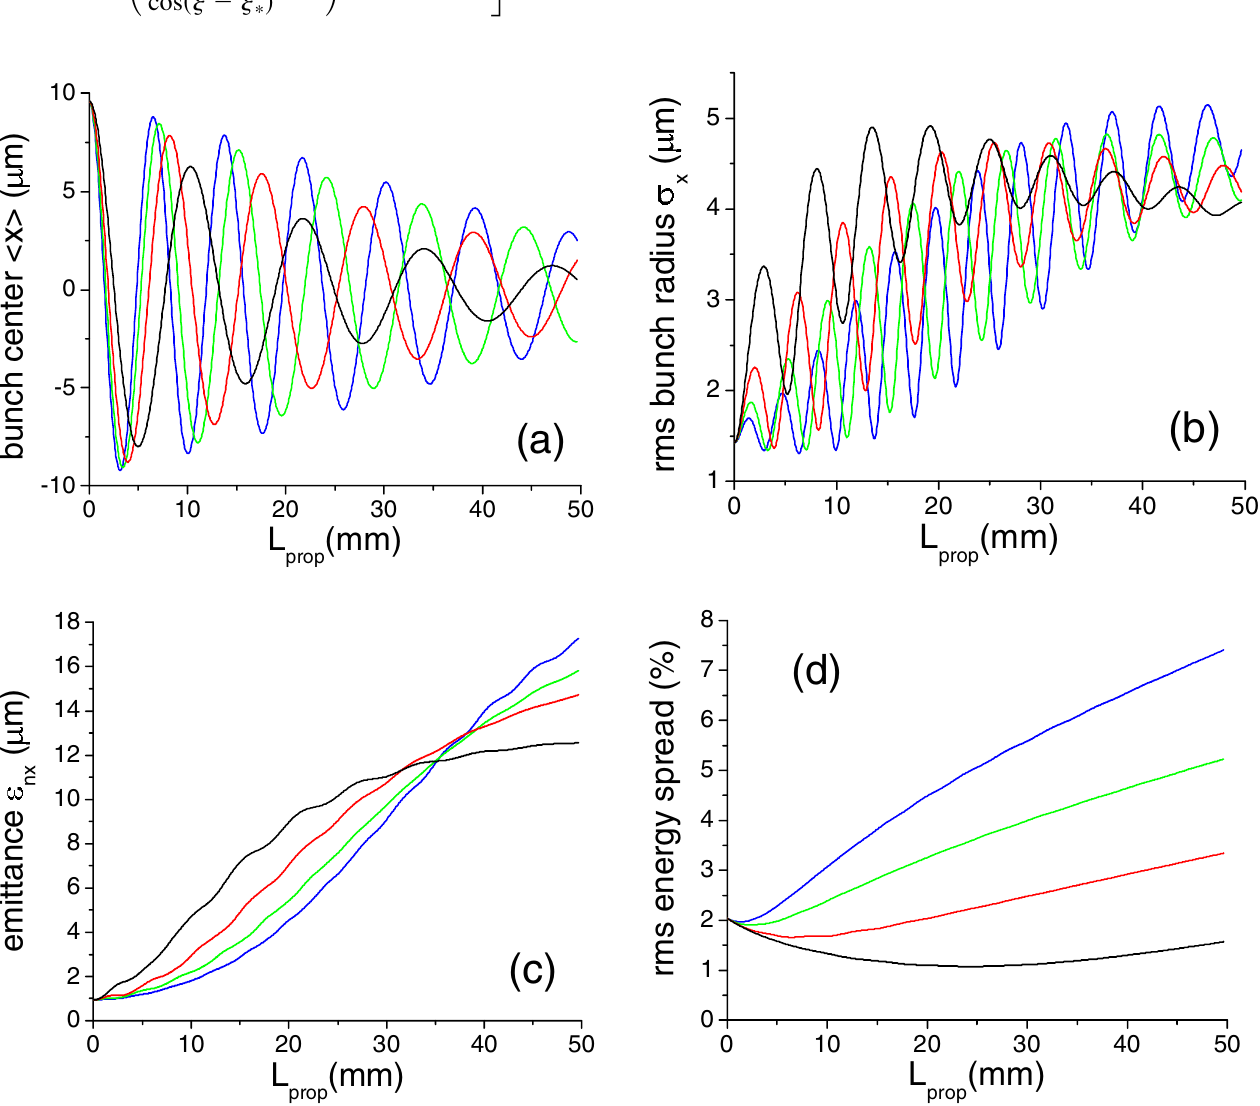
FIG. 9. (Color) Evolution of parameters of a femtosecond electron bunch injected off-axis into the laser wakefield, at different phases of the field. The bunch is injected at (cid:6) (cid:1) (cid:2) 9 : 6 (see Figs. 1 and 2; this case corresponds to the black curves), at (cid:6) (cid:1) (cid:2) 9 : 3 (red curves), at (cid:6) (cid:1) (cid:2) 9 (green curves), and at (cid:6) (cid:1) (cid:2) 8 : 7 (blue curves). Initially h x i (cid:1) 9 : 55 (cid:1) m , h y i (cid:1) 0 , mean bunch energy is 204.4 MeV ( h (cid:4) i (cid:1) 1 : 43 (cid:1) m , " (cid:1) 0 : 95 (cid:1) m , and the rms energy spread is 400 ), FWHM duration is 7.5 fs, (cid:7) x;y nx;y